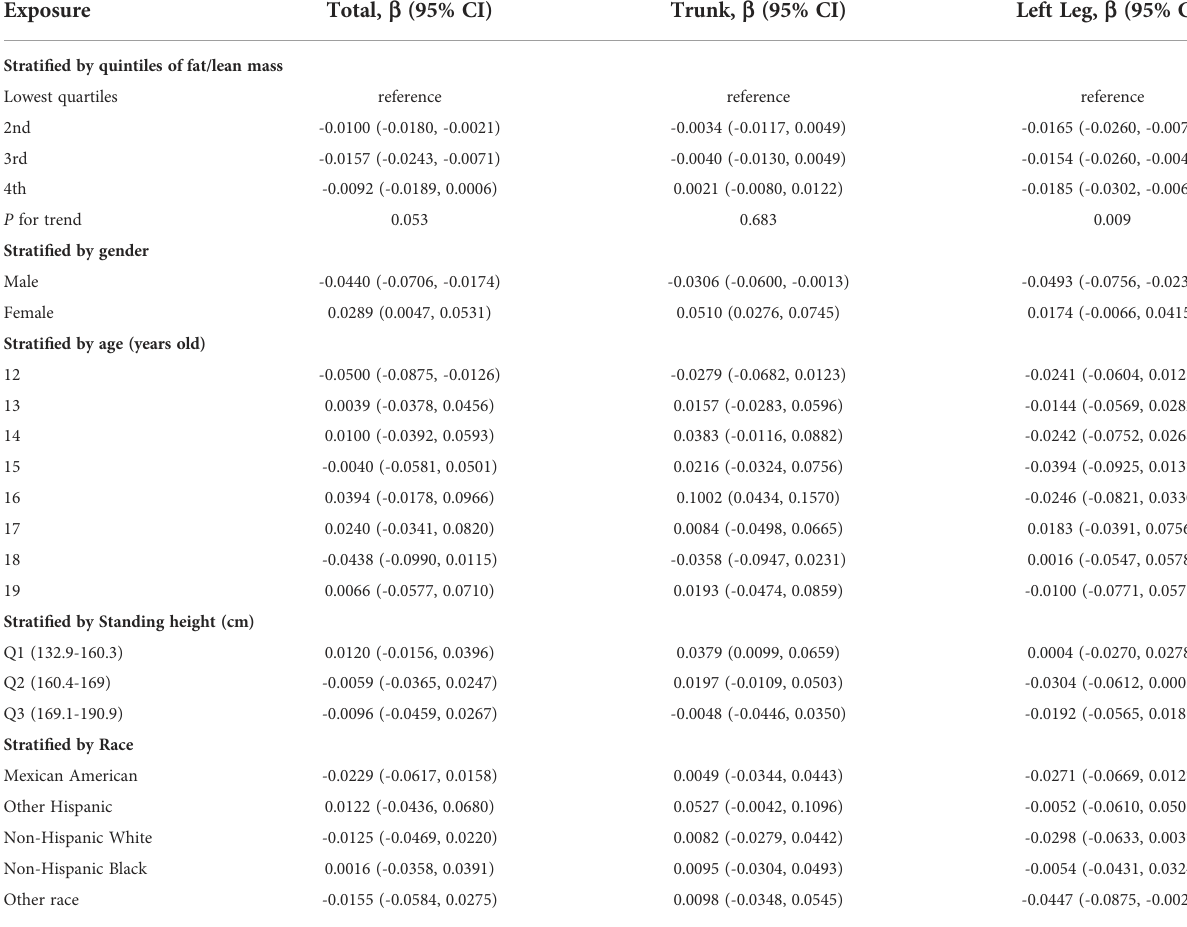
TABLE 5 Association between fat/lean mass and bone mineral density (g/cm 2 ) of corresponding parts of the body.